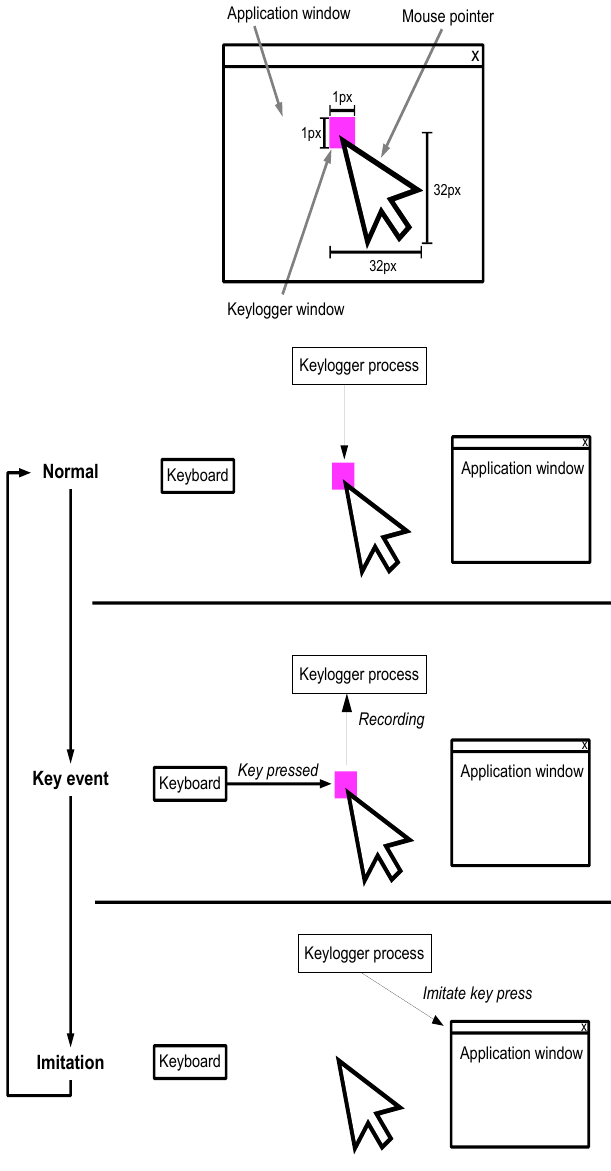
Figure 4. Overview of Mouse